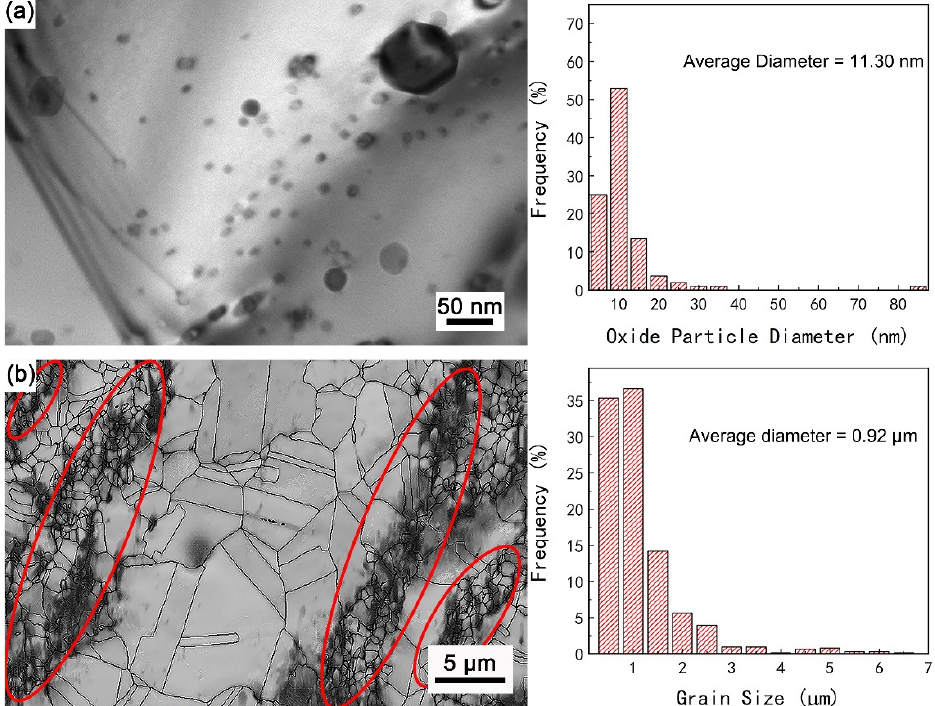
Figure 2. ( a ) TEM image and size distribution of secondary phase oxides and ( b ) EBSD image and size distribution of grains in as ‐ HIP ‐ treated S2. The fine grain regions with secondary phase oxides are marked with red circles.